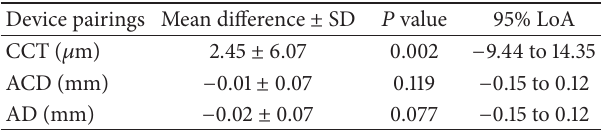
Table 1: Comparison of central corneal thickness (CCT), anterior chamber depth (ACD), and aqueous depth (AD) measured by the AL-Scan partial coherence interferometry and Visante optical coherence tomography.